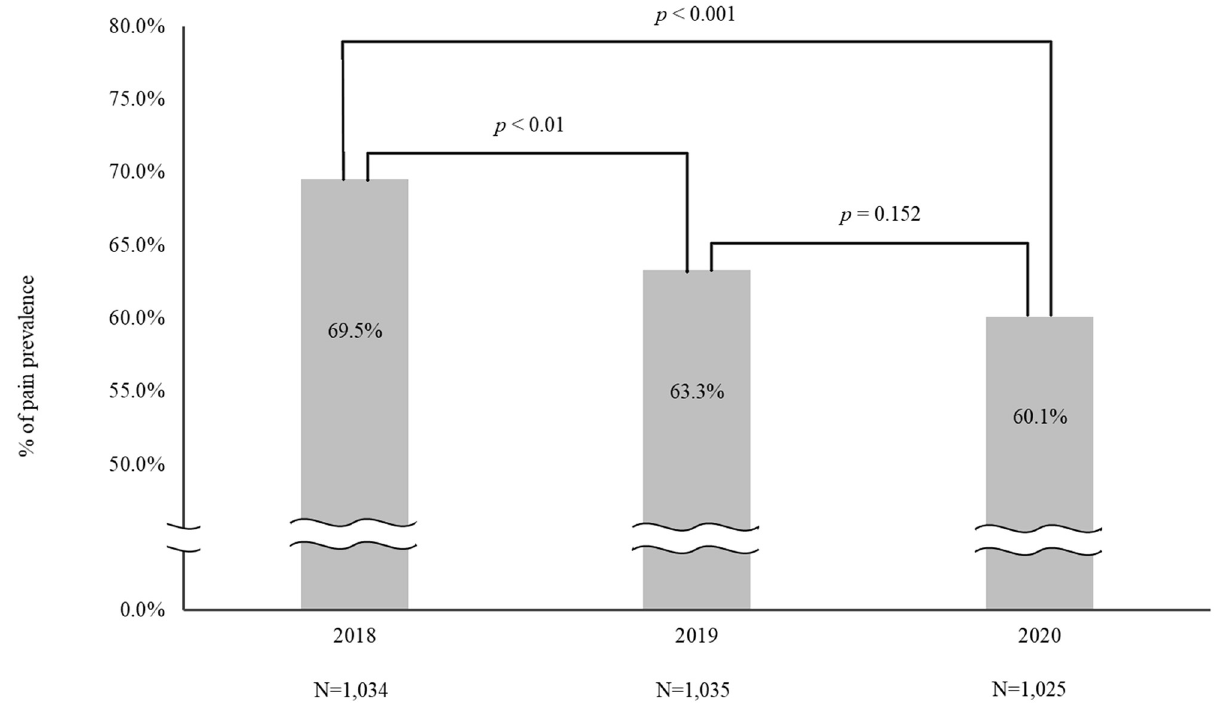
Fig 2. Decrease of pain prevalence after implementing the hospitalized-wide pain management program from 2018 to 2020.